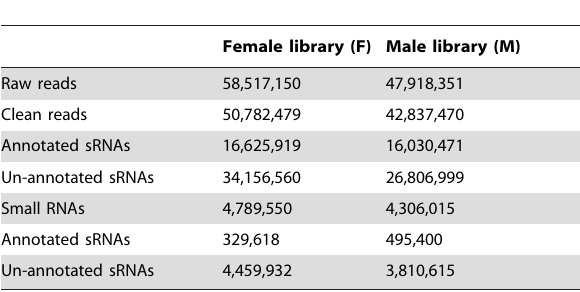
Table 1. Summary of small RNA sequences from P . tomentosa female and male